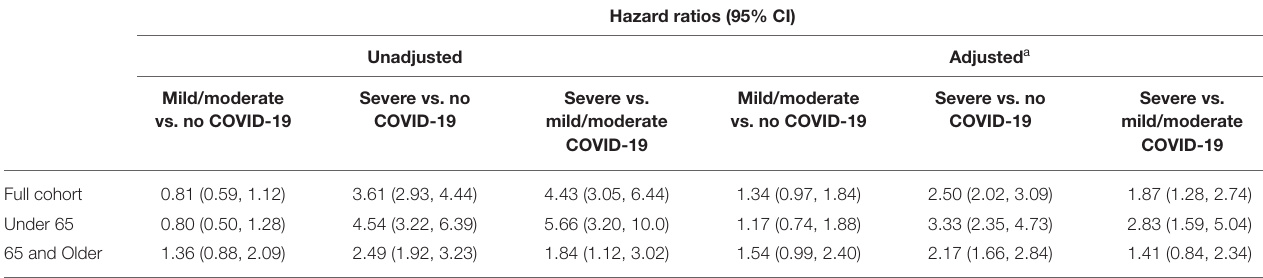
TABLE 3 | All-cause mortality hazard ratios by COVID-19 status for conditions other than